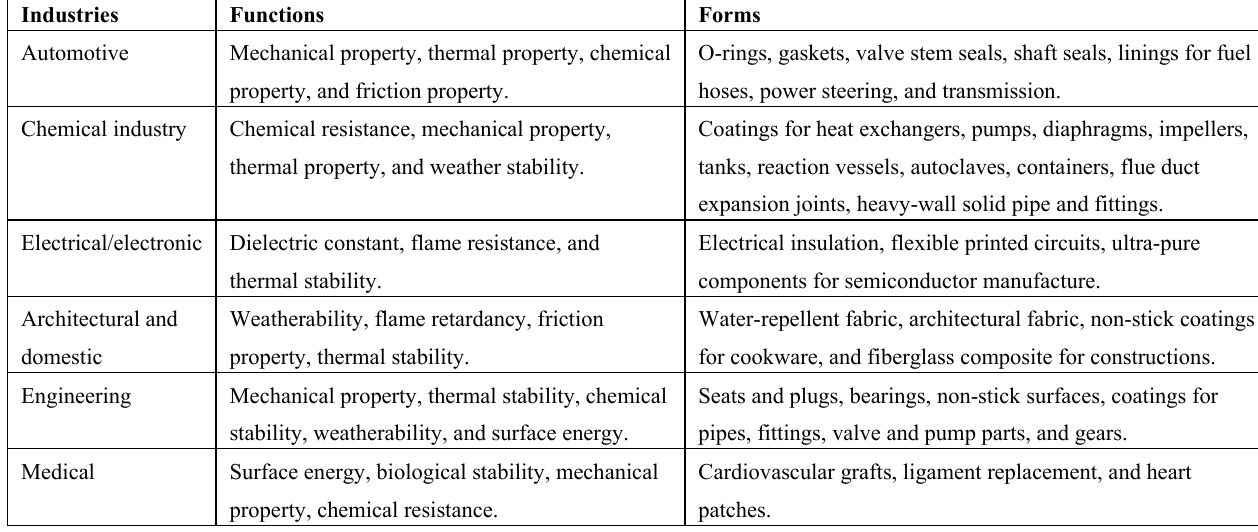
Table 1. Typical applications of fluoropolymers for different industry segments.